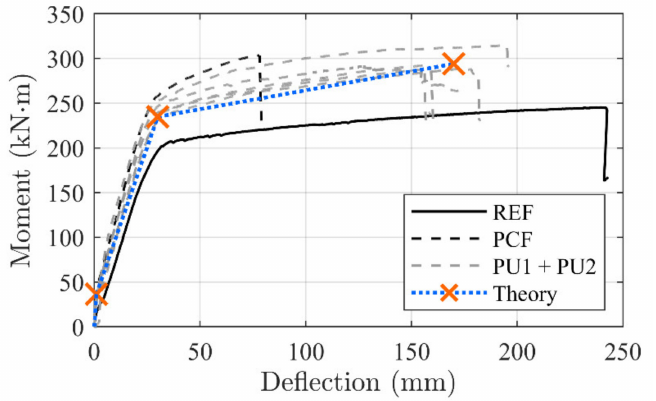
Figure 17. Stress variation along the CFRP bar for the different